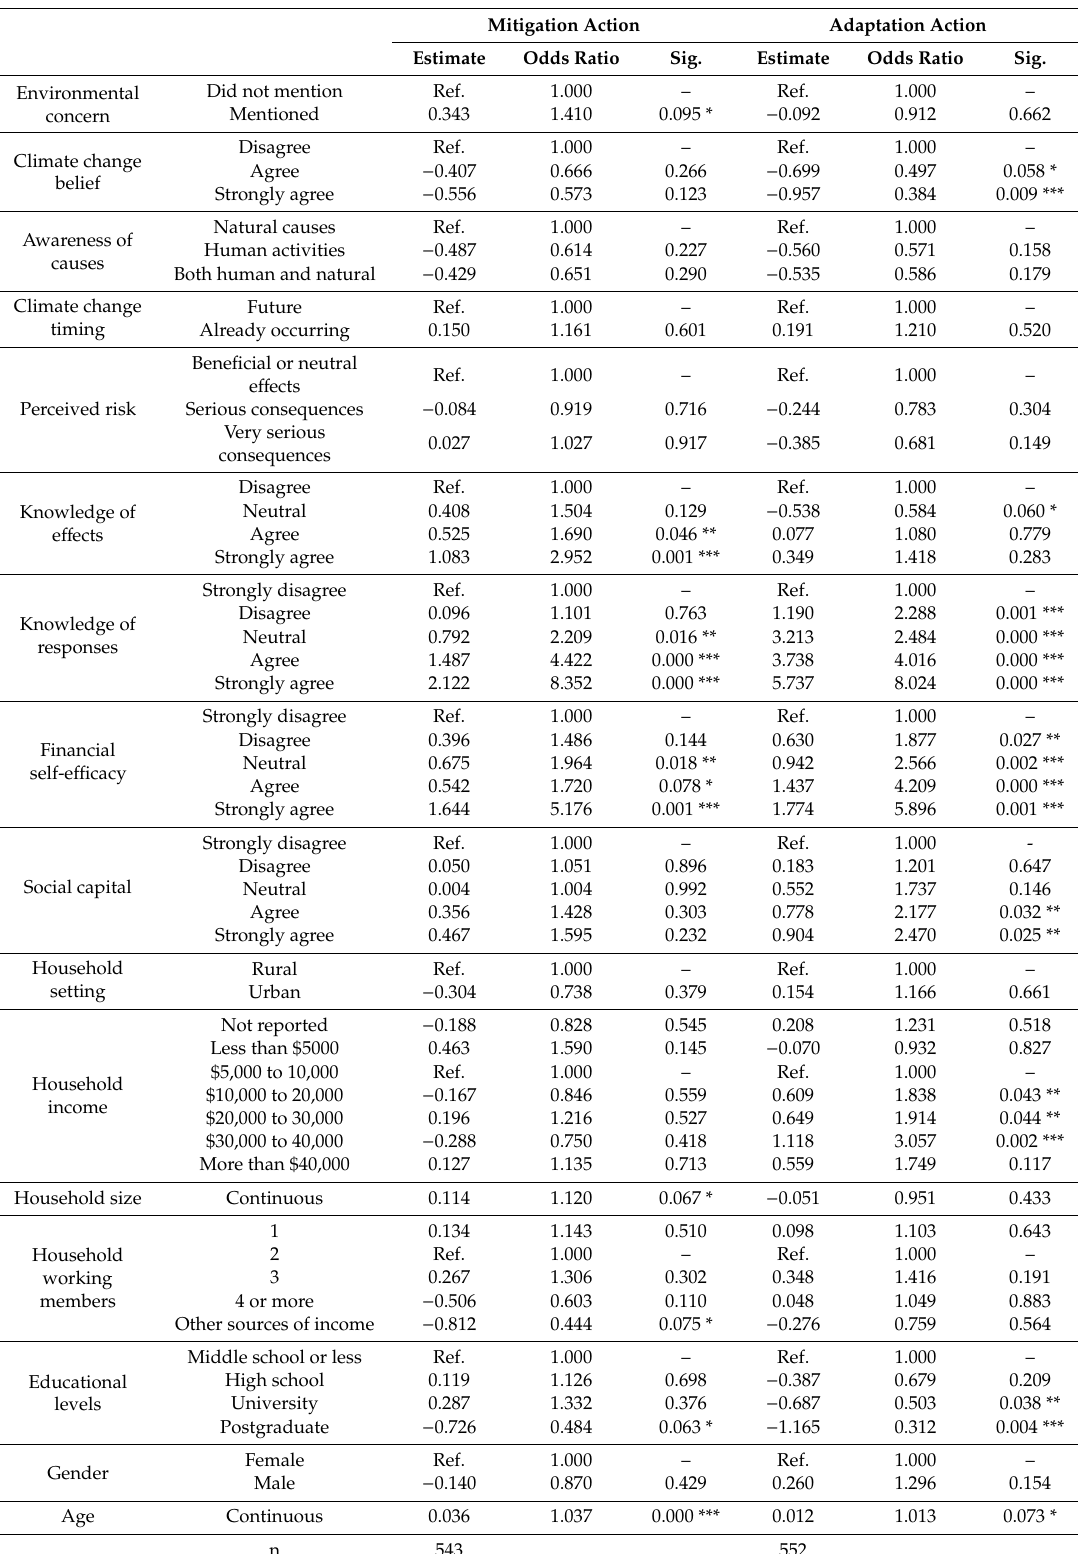
Table 3. Ordinal regression results in factors influencing the implementation of mitigation and adaptation actions among households in Nuevo Leon, Mexico (N =